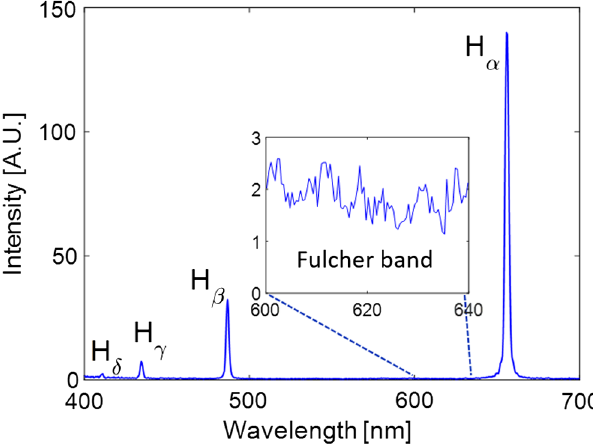
FIG. 1. Example of hydrogen spectrum used for achieving the PS-ESS plasma